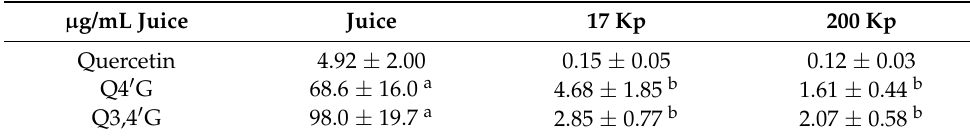
Figure 1. Profiles of nanoparticles identified from Allium cepa L. Nanoparticles were identified as 17,000 × g and 200,000 × g precipitates, referred to as 17 Kp and 200 Kp, respectively. ( A ): Appearance of 17 Kp and 200 Kp; ( B , C ): Diameters of 17 Kp and 200 Kp were measured by dynamic light scattering method. B shows the average diameter and C shows the distribution of the diameter. ( D ): Protein profiles analyzed by SDS-PAGE and silver staining. Red arrows show specific bands found in 200 Kp. ( E ): Small RNA profiles analyzed by PAGE. Small RNA purified from 17 Kp and 200 Kp were treated with or without RNAseA before loading to the electrophoresis. Table 1. Content of quercetins in onion juice, 17 Kp and 200